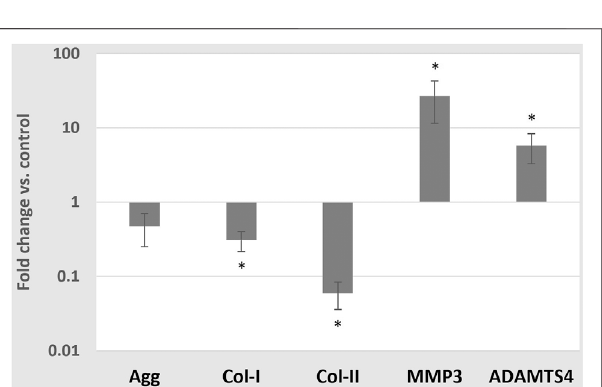
FIGURE 7 | Average mRNA expressions (logarithmic scale) and standard deviations of extracellular matrix proteins and proteases after exposing cells to 10 ng/ml TNF- α , 5 mM glc and pH 7.4. *: signi fi cantly ( p < 0.05) different from control